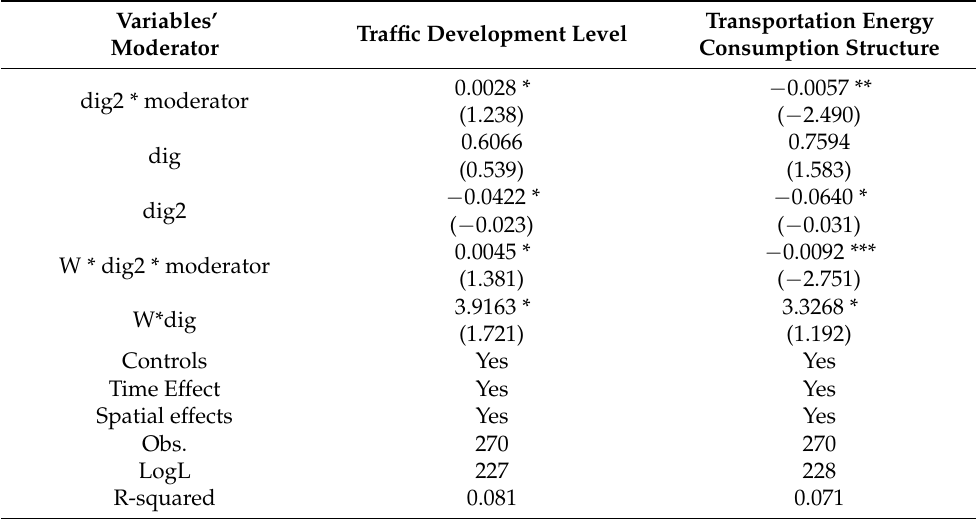
Table 12. Analysis of the mechanisms by which the level of digital innovation affects carbon emissions in the transport